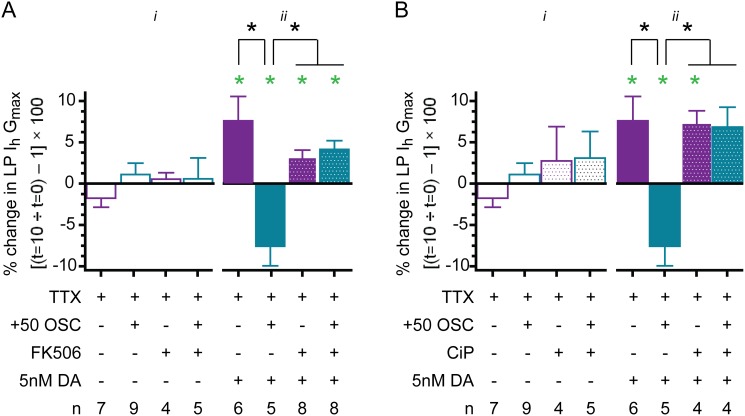
Calcineurin acts as a Ca2+ sensor for metamodulation of LP Ih in 5nM DA.
(A) The effect of blocking calcineurin with bath applied FK506. Experiments were performed as described for Fig. 5 using the calcineurin inhibitor, FK506. The percent change in LP Ih Gmax at t = 10min relative to t = 0 (mean+SEM) was plotted. Paired t-tests compared t = 10min vs. t = 0 within each treatment group; green asterisk, p<0.05. Black asterisks indicate that a one-way ANOVA on the four DA-treatment groups with Tukey’s post hoc tests that made all pair wise comparisons showed that the decrease observed for the TTX + DA + (+50 OSC) treatment group was significantly different from the other three DA treatment groups, and that those three DA treatment groups [(TTX+DA, TTX+DA+FK506, TTX+DA+FK506+(+50 OSC)] were not significantly different from one another: (F (3,26) = 11.08; p = 0.0001). There were no significant differences between the 4 treatment groups that did not receive DA, One way ANOVA, F(3,24) = 0.7714, p = 0.5229. (B) The effect of calcineurin autoinhibitory peptide (CiP) injections. Experiments in Fig. 5 were repeated except PKI was omitted and CiP was injected into LP at-20min. Paired t-tests compared t = 10min vs. t = 0 within each treatment group; green asterisk, p<0.05. Black asterisks indicate that a one-way ANOVA on the four DA-treatment groups with Tukey’s post hoc tests that made all pair wise comparisons showed that the decrease observed for the TTX + DA + (+50 OSC) treatment group was significantly different from the other three DA treatment groups, and that those three DA treatment groups [(TTX+DA, TTX+DA+CiP, TTX+DA+CiP+(+50 OSC)] were not significantly different from one another: (F (3,18) = 8.71; p = 0.0014). There were no significant differences between the 4 treatment groups that did not receive DA, One way ANOVA, F(3,24) = 1.024, p = 0.4019.